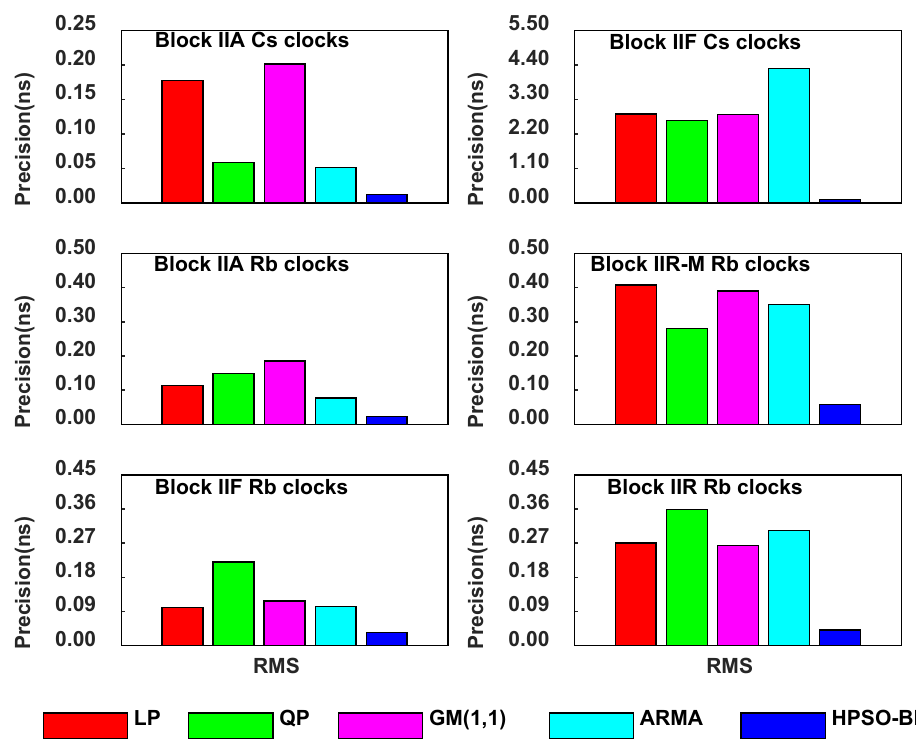
Figure 6. Prediction precision bar chart for six types of satellite clocks in 60 min for 30 January 2019.